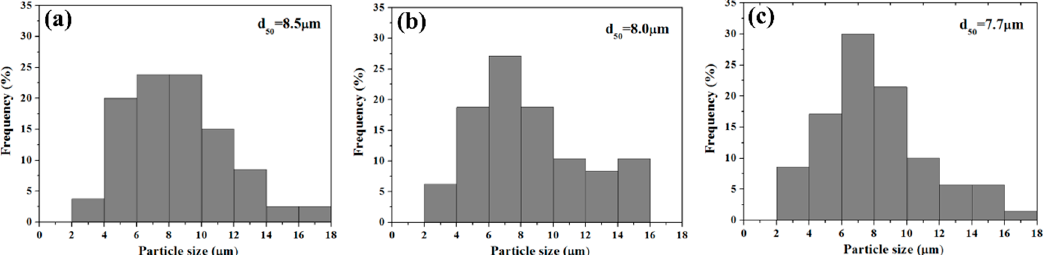
Figure 5. Particle size distributions of spray dried ( a ) 58S, ( b ) 68S, and ( c ) 76S BG powders.